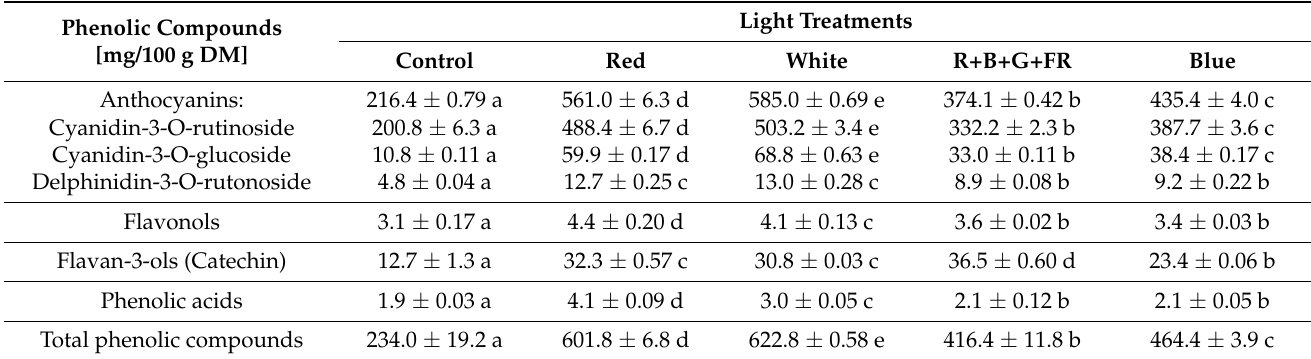
Table 4. Phenolic compounds of rhubarb ‘Raspberry’ plantlets during ex vitro growth in the green- house. Means indicated with the same letter within individual polyphenolic type are not significantly different ( p = 0.05) according to Duncan’s test; the lowest value is marked with